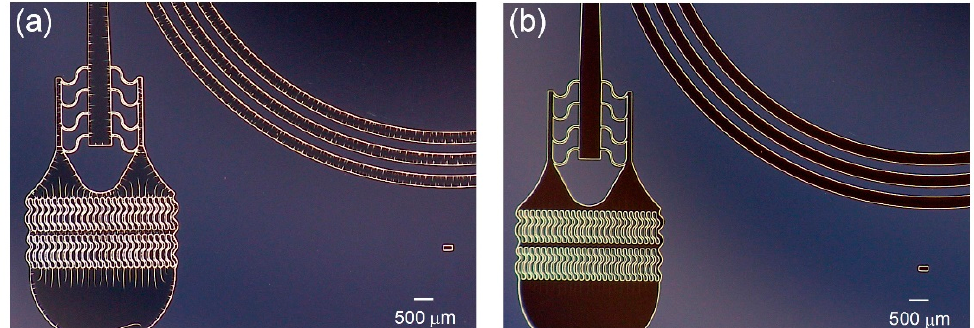
Figure 5. Images of an ADEX master before and after annealing. ( a ) Sub-micron cracks appear upon development in cyclohexanone in some films. ( b ) However, these cracks can be removed by annealing at 150 °C for 90 min.